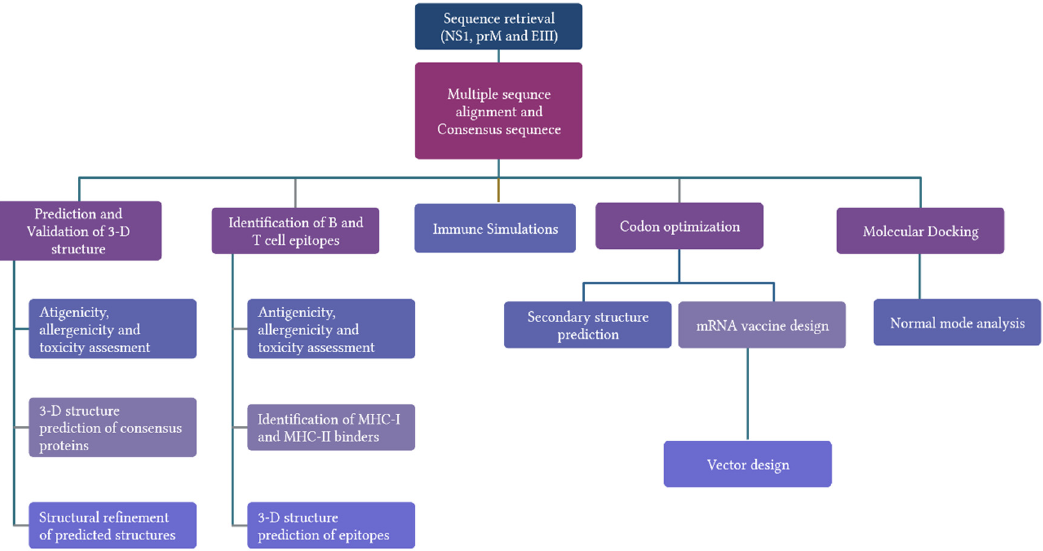
Figure 14. Graphical illustration of workflow of development of mRNA vaccines against dengue